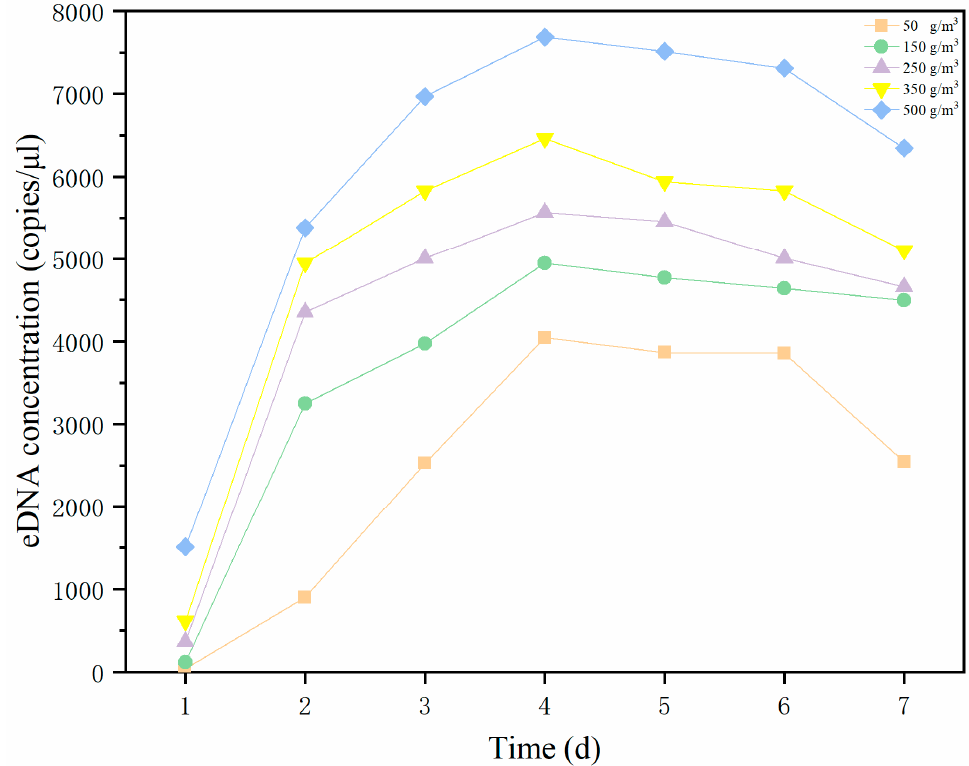
Figure 1. Variation in the A. latus eDNA concentration. Different coloured shapes represent different yellowfin seabream biomasses. The x-axis represents the number of days, and the y-axis represents the eDNA concentrations (copies/ μ L).